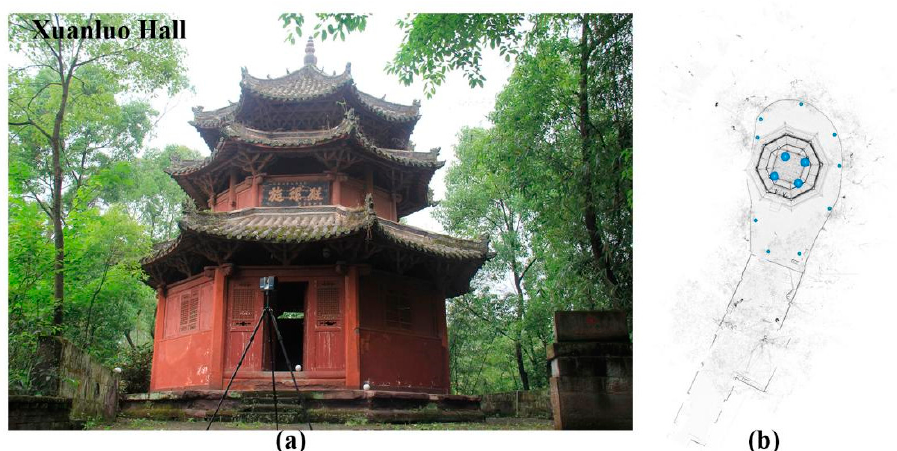
Figure 13. Xuanluo Hall scanning. ( a ) Faro Laser Scanner used in this work; ( b ) distribution of stations.